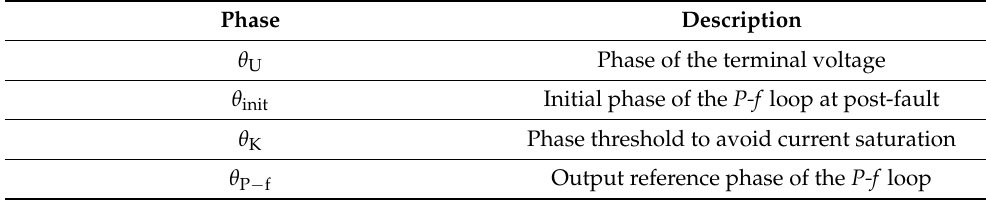
Table 1. Description of different